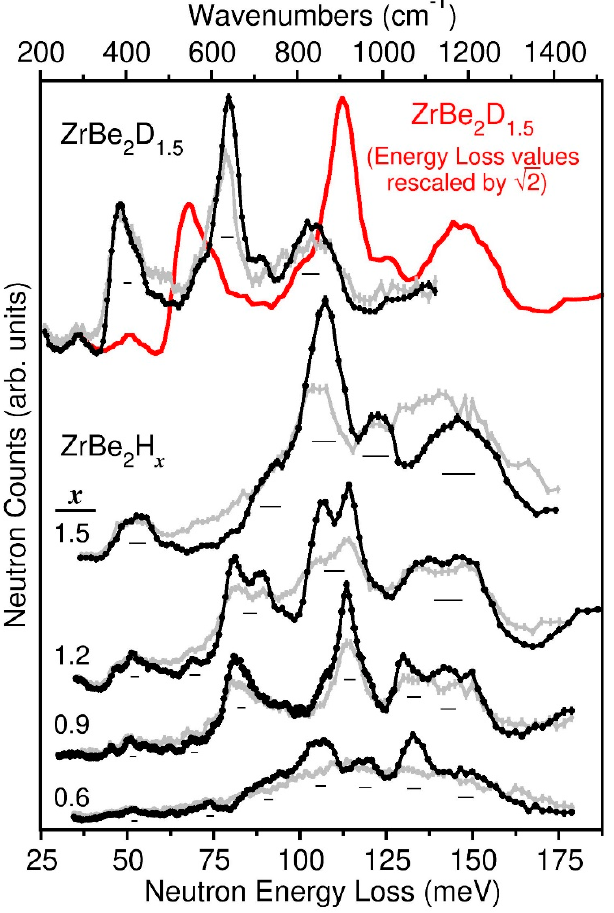
Figure 7. Neutron vibrational spectra of ZrBe 2 D 1.5 and ZrBe 2 H x ( x = 0.6, 0.9, 1.2, 1.5) samples. Black spectra were measured at 10 K. Gray spectra were measured at room temperature except for ZrBe 2 H 0.6 , which was measured at 480 K. Red spectrum reflects the 10 K ZrBe 2 D 1.5 spectrum after rescaling the neutron energy loss values by √2 . ZrBe 2 H x spectra are roughly normalized to the same ZrBe 2 mass and all spectra are vertically offset for clarity. Full-width-at-half-maximum instrumental resolutions are depicted by the horizontal bars beneath the spectra. ( N.B. , 1 meV ≈ 8.0655 cm − 1 )